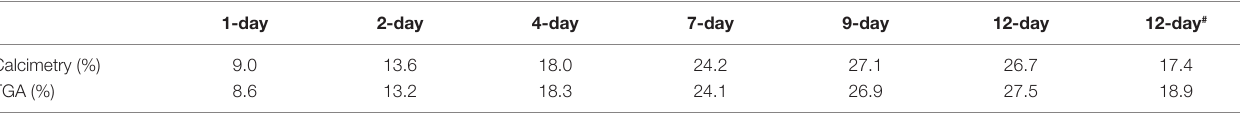
TaBle 1 | Degree of carbonation of casiO 3 powder calculated from calcimetry and Tga